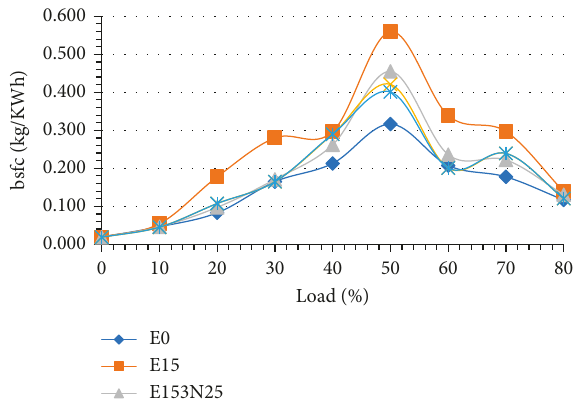
Figure 16: The effect of 3 elemental nanoparticles addition in E15 on engine fuel